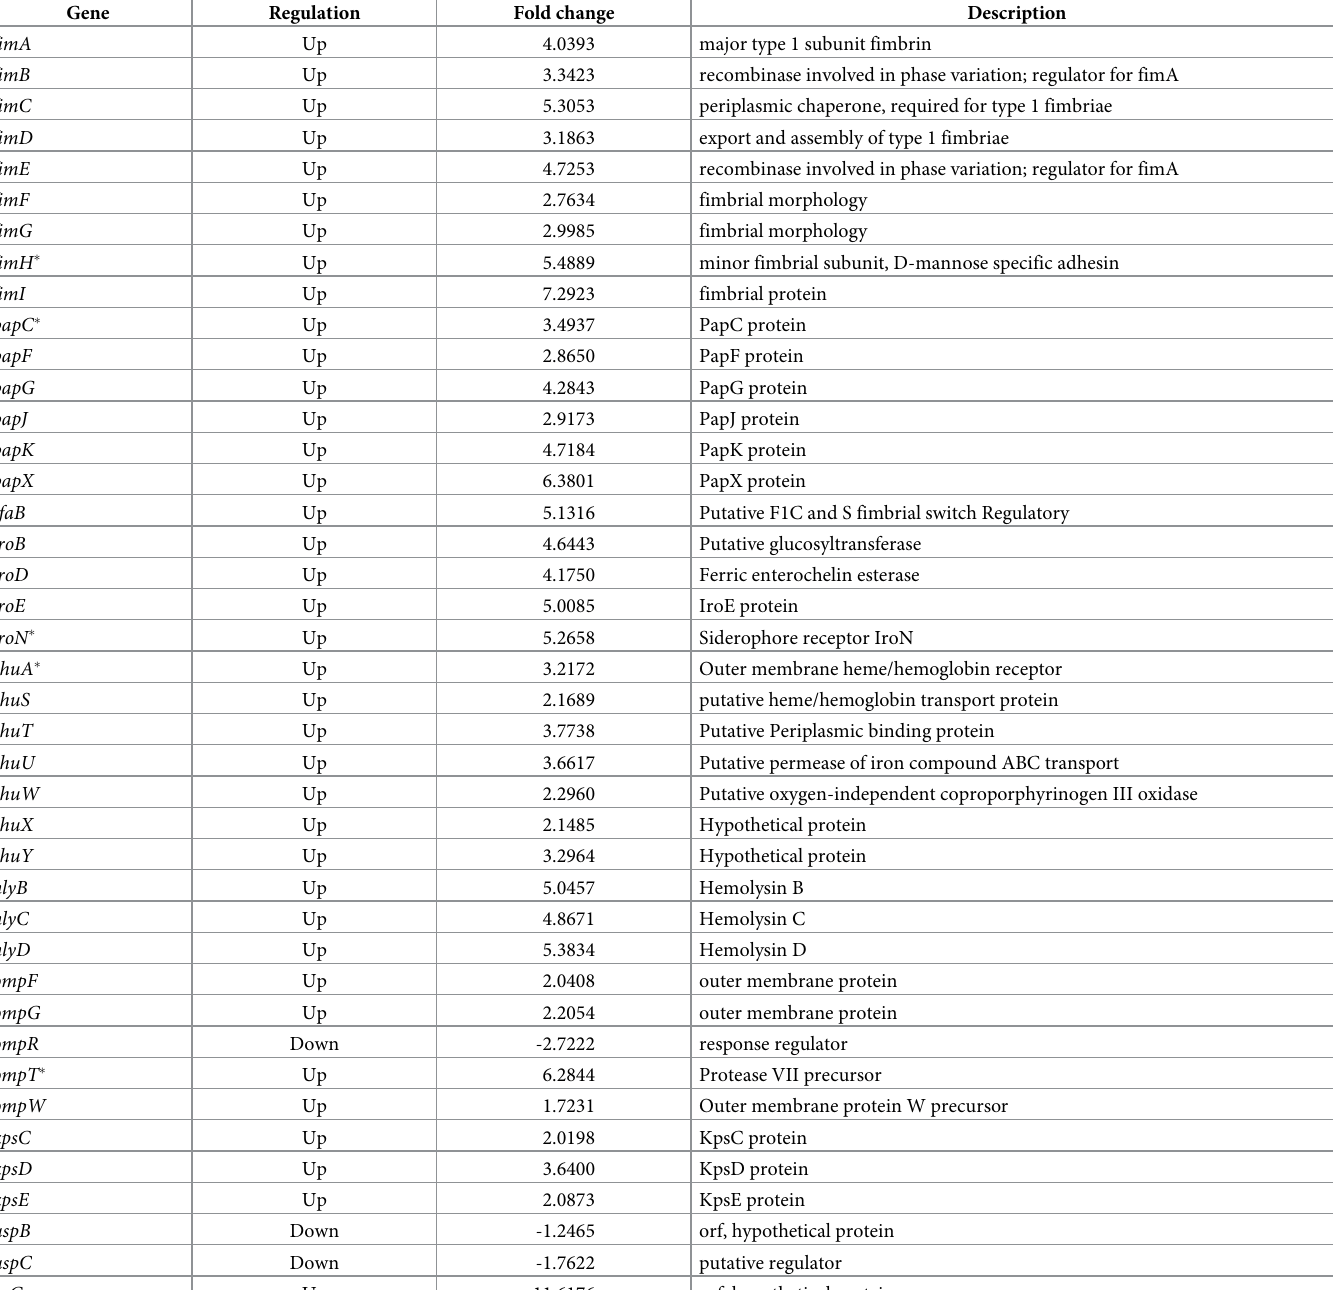
Table 5. Significant differentially expressed virulence genes among ASB EC095 (high pathogenic potential) strain compared to EC114 (low pathogenic potential) strain using microarray